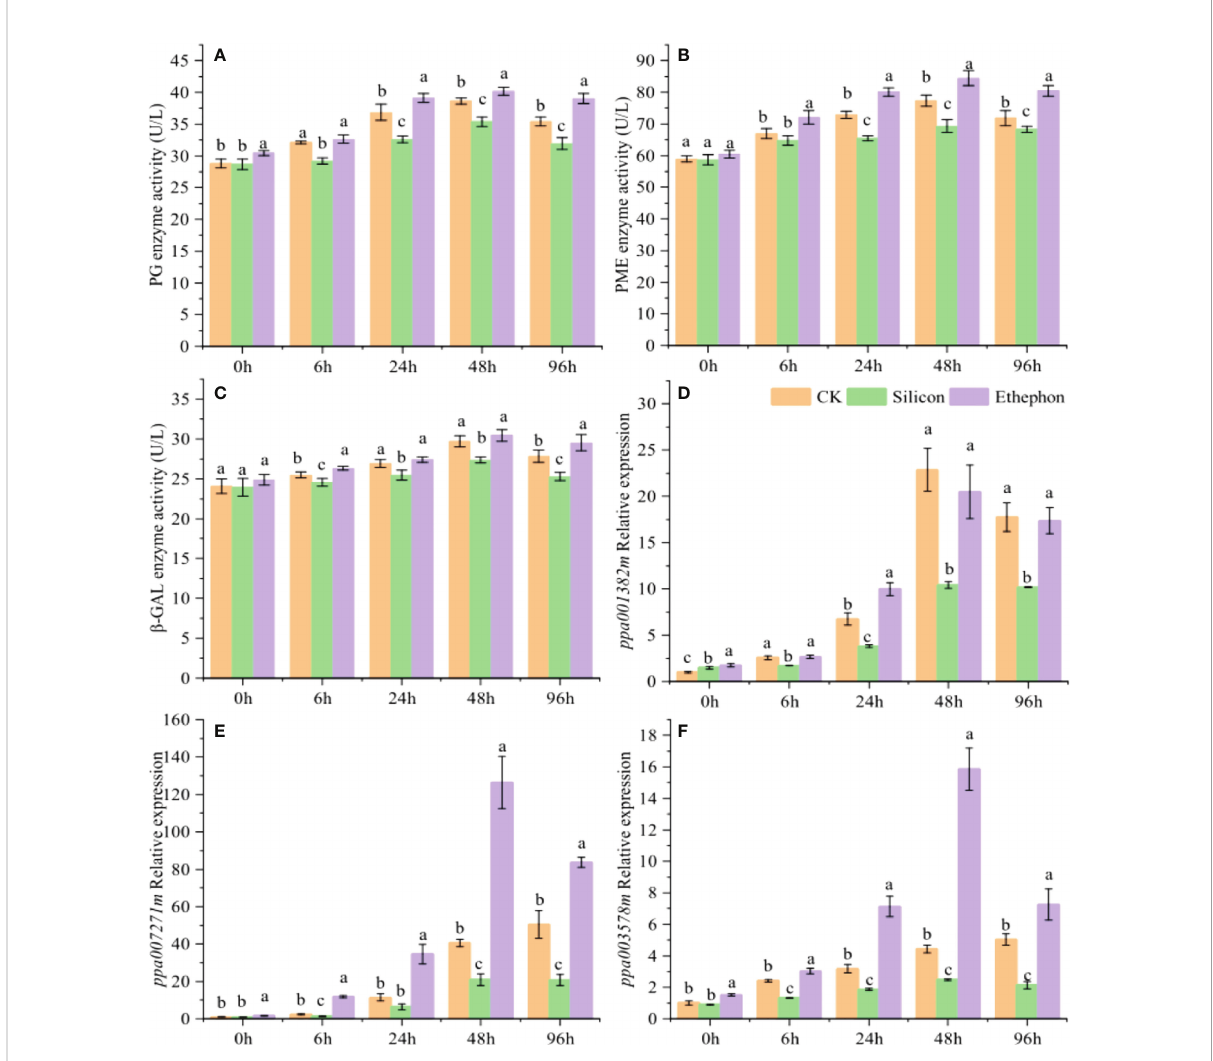
FIGURE 2 Silicon inhibits cell wall-degrading enzyme activity in peach shoots. Enzyme activity of PG (A) , PME (B) and b -Gal (C) in peach shoots. Relative expression of ppa007271m (D) , ppa003578m (E) and ppa001382m (F) in peach shoots. The peach shoots were treated with water, Na 2 SiO 3 (0.6 mmol/L) or ethephon (1%, w/w), and samples were taken at different times to determine the enzyme activity and relative gene expression. Bars with different letters indicate signi fi cant differences (p < 0.05, Duncan ’ s multiple range